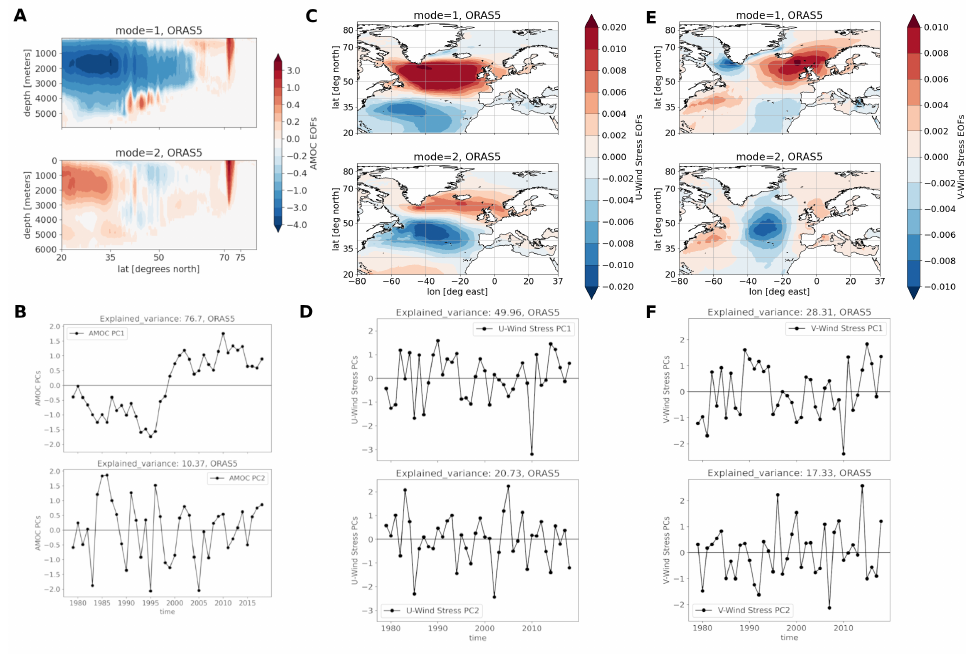
Figure 3. ( A ) EOF patterns for the AMOC stream function. ( B ) corresponding PCs with explained variances in the title of the subplot; data from ORAS5. ( C ) EOFs patterns for a zonal component of wind stress; data from ORAS5. ( D ) Correspondent PCs rescaled to have unitary variance. ( E ) EOFs patterns for meridional component of wind stress. ( F ) Correspondent PCs rescaled to have unitary variance; data from